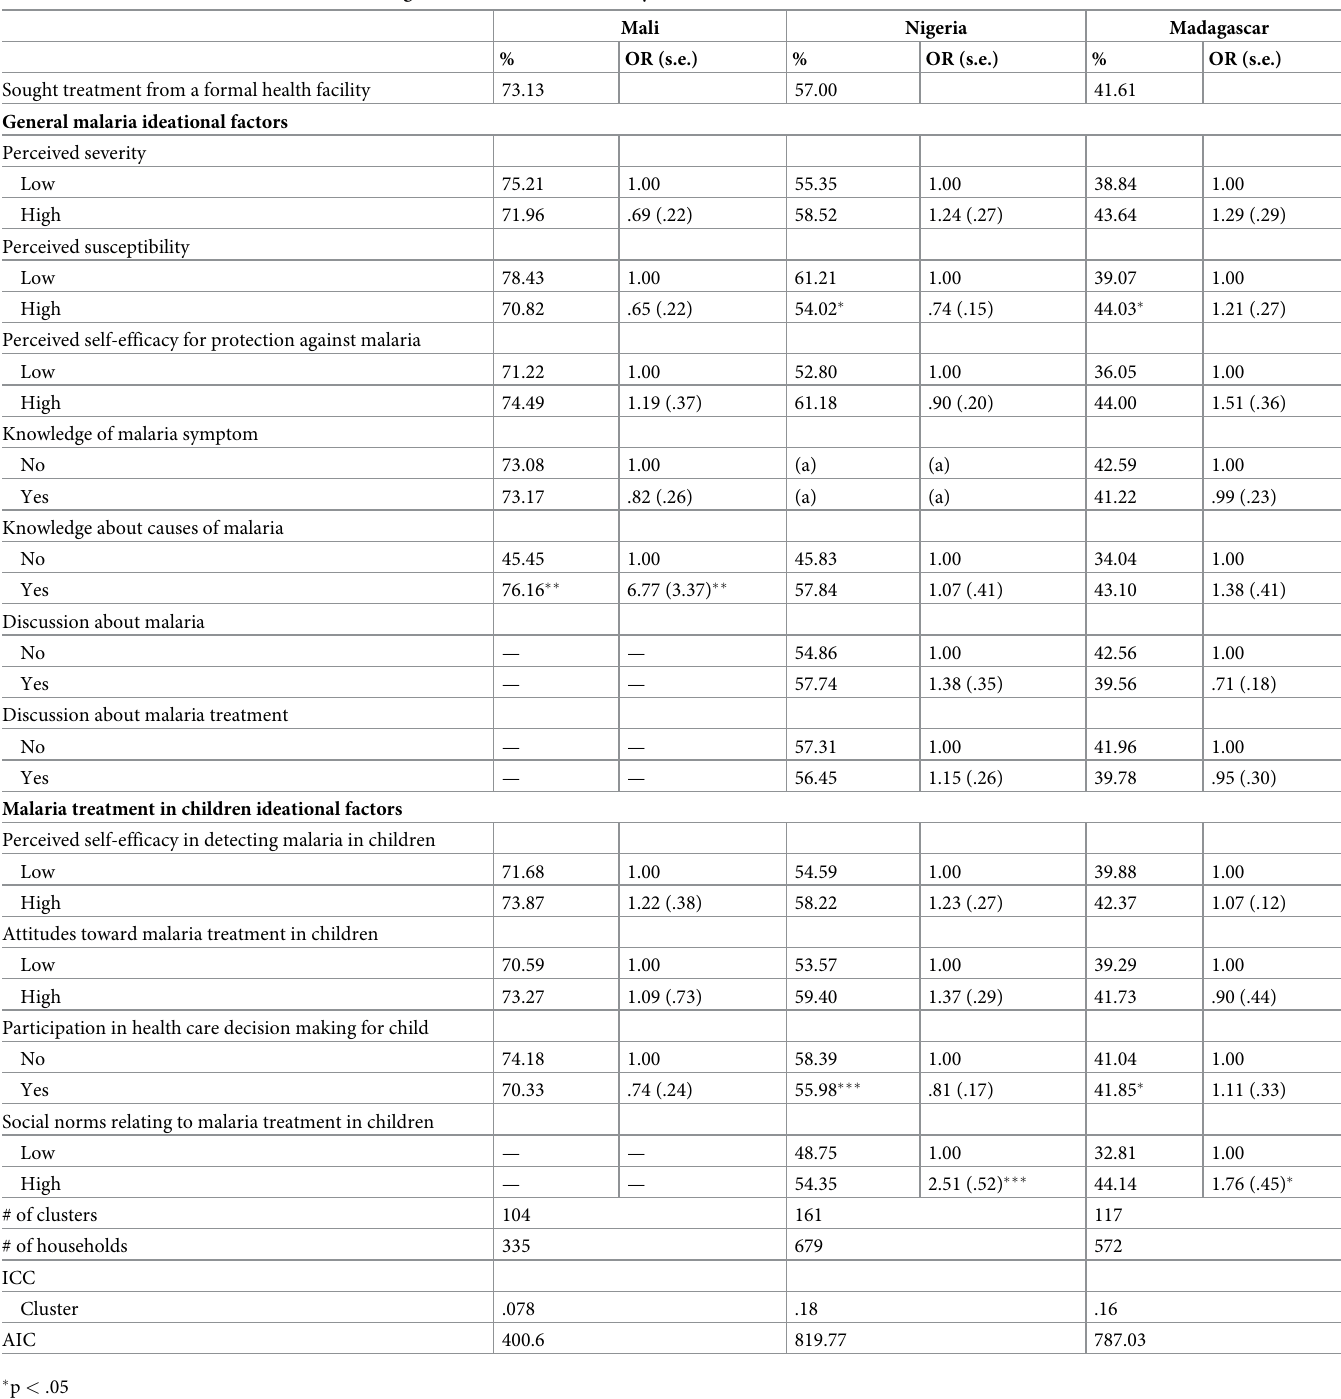
Table 3. Ideational factors related to care-seeking from a formal health facility for children under five who had fever in the last two weeks. Mali Nigeria Madagascar % OR (s.e.) % OR (s.e.) % OR